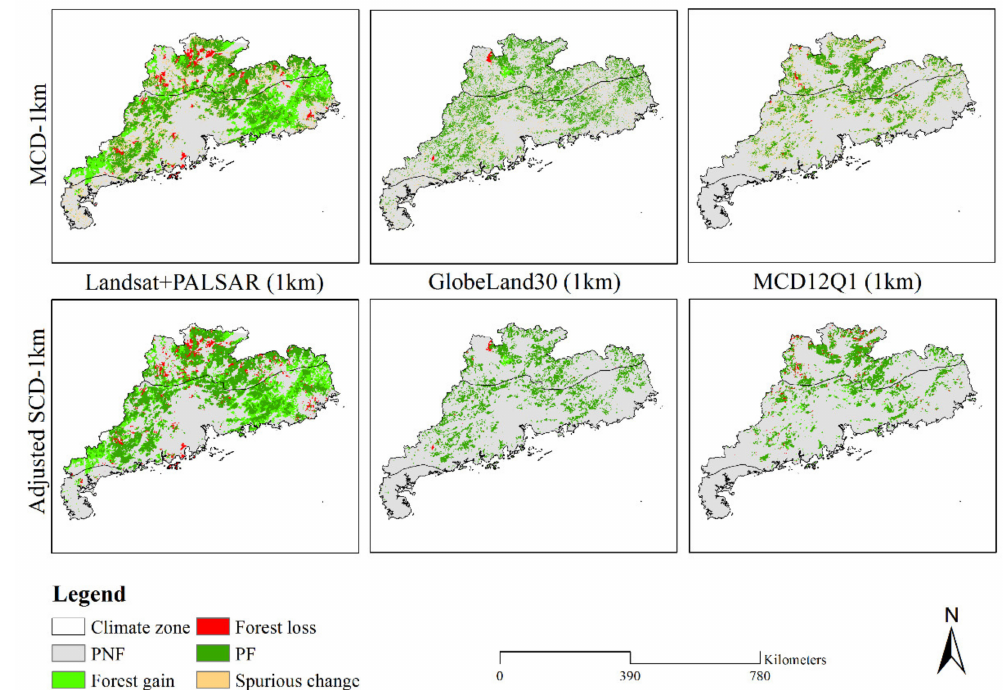
Figure 4. Change in forest cover estimated by the morphological change detection (MCD) and adjusted simple change detection (SCD) methods based on the three datasets for 30-m, 500-m, and 1-km resolutions between 2000 and 2010 showing the spatial and temporal patterns of unchanged non-forest, unchanged forest, forest gain, and forest loss in Guangdong Province,